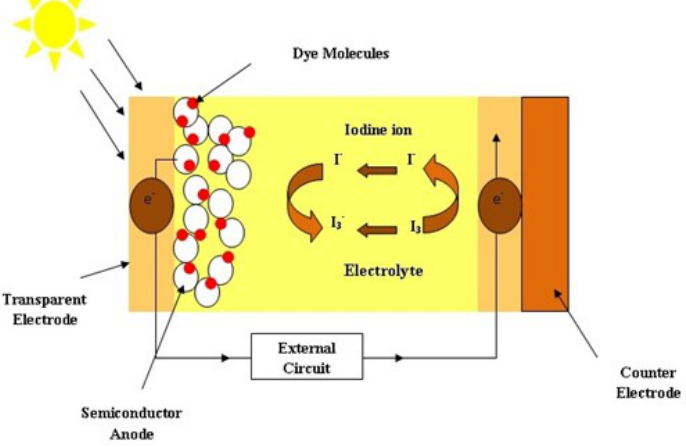
Figure 1. Working of a typical dye-sensitized solar cell .